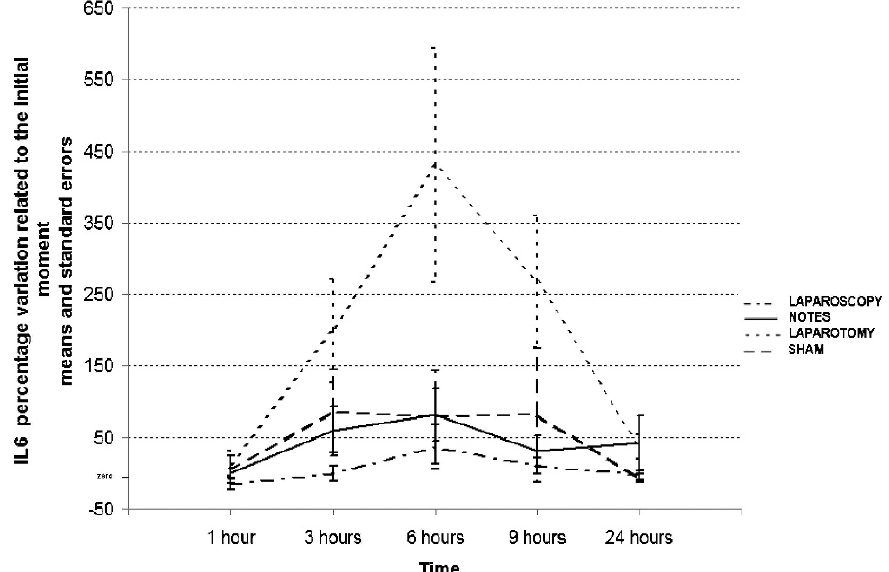
Figure 1 - IL-6 variation with time in all